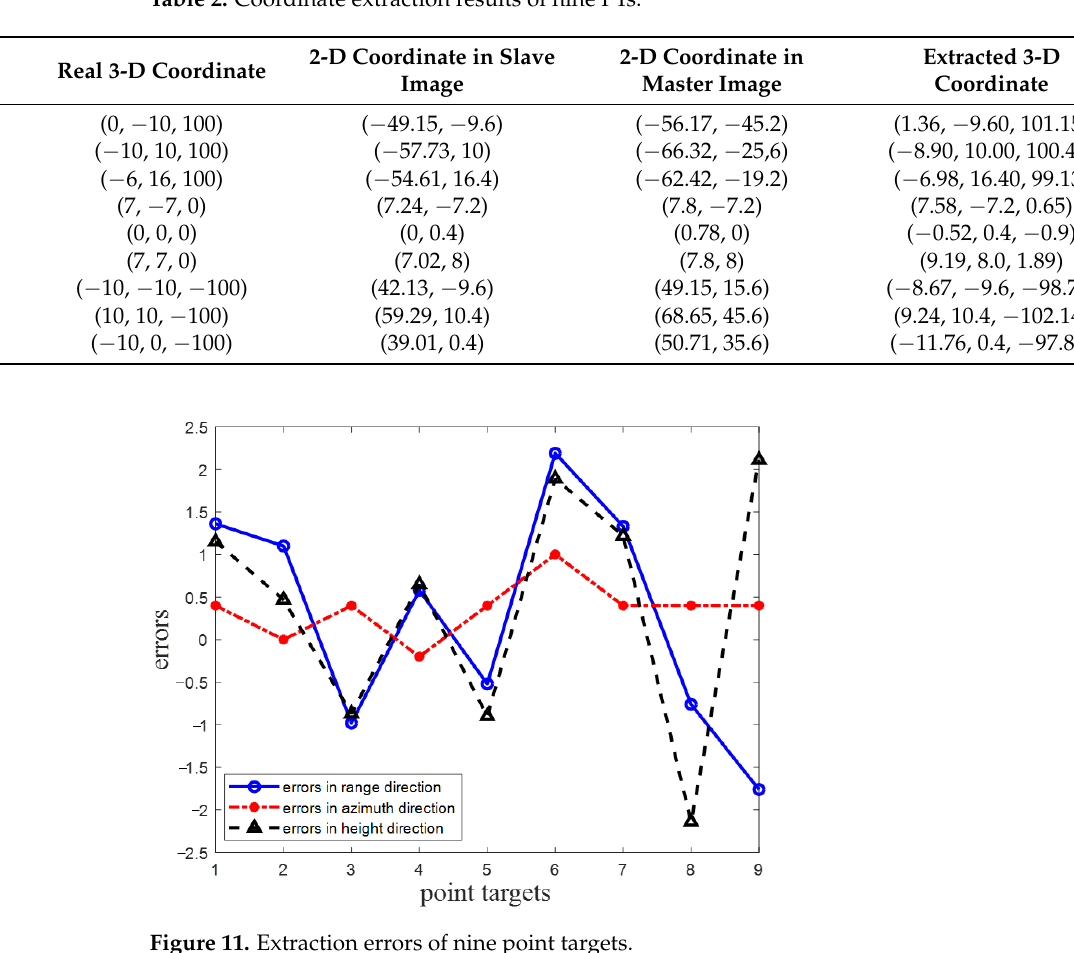
Figure 9. Imaging results of two different sub-apertures. ( a ) Result of the slave image; ( b ) result of the master image.